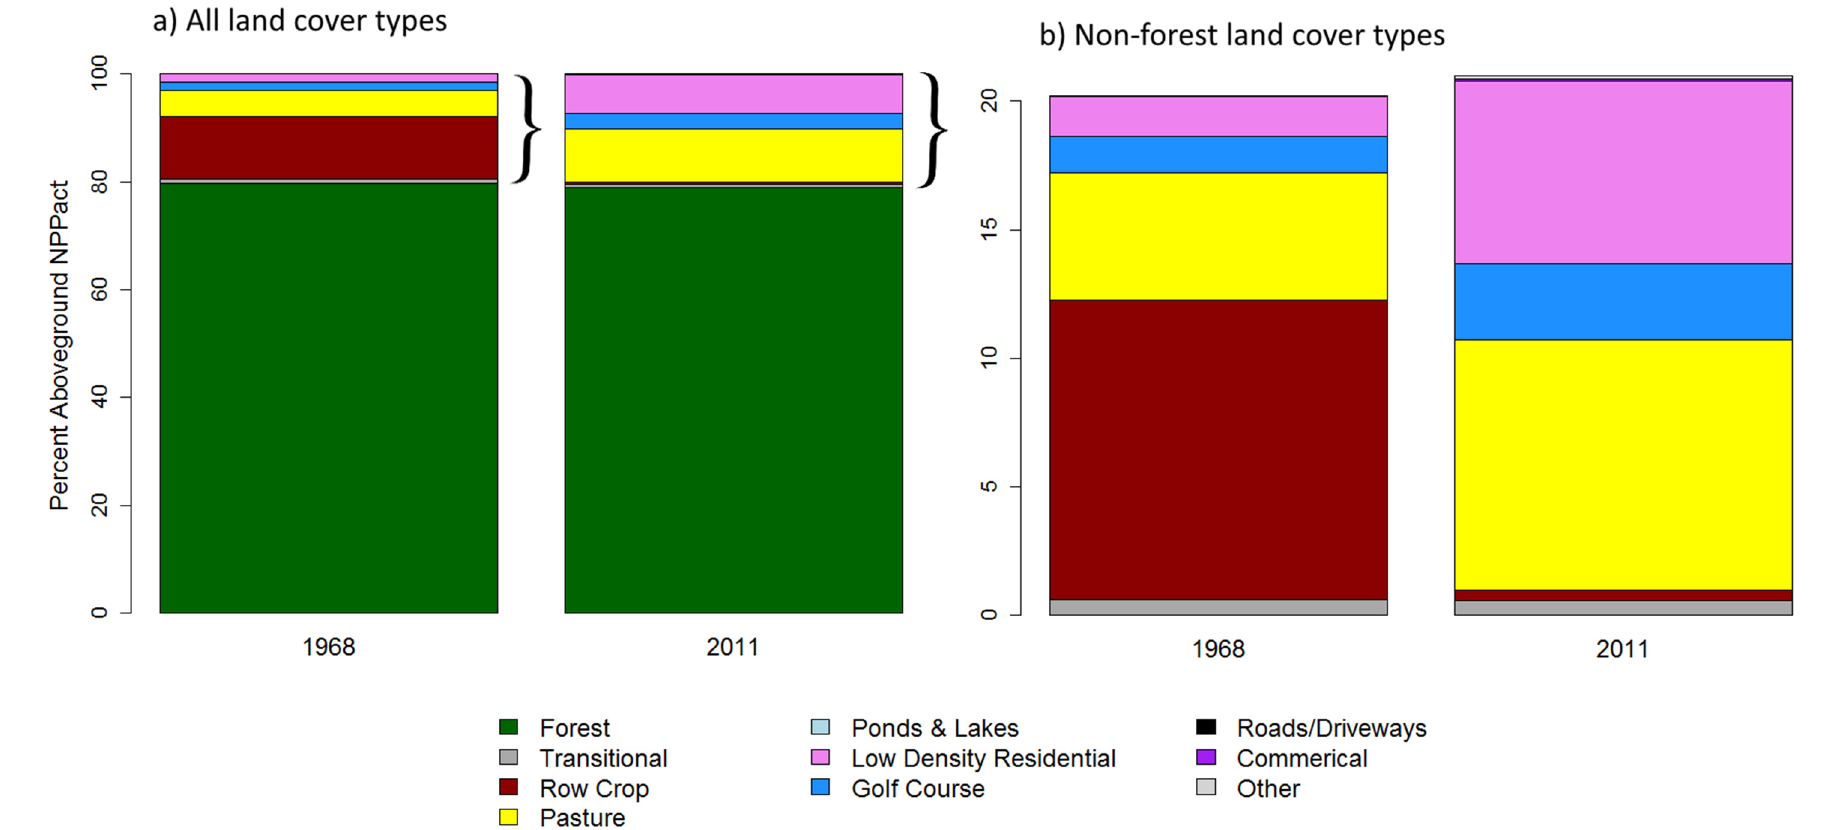
Figure 6. Percentage of aboveground NPP act in the Doddies Creek watershed for all ( a ) land cover types and ( b ) non forest land cover types in 1968 and 2011. Aboveground NPP act for the entire watershed was 13.7 Gg·C·y − 1 in 1968 and 13.8 Gg·C·y − 1 in 2011. A similar pattern of change was observed for total NPP act